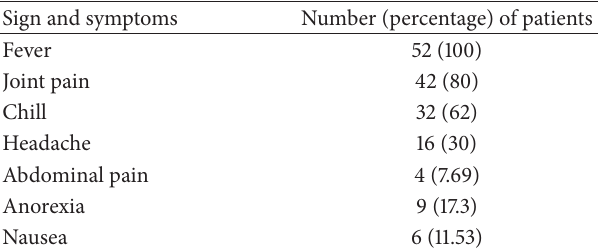
Table 2: Quantification of Chikungunya viral RNA in clinical samples and mosquito pools by